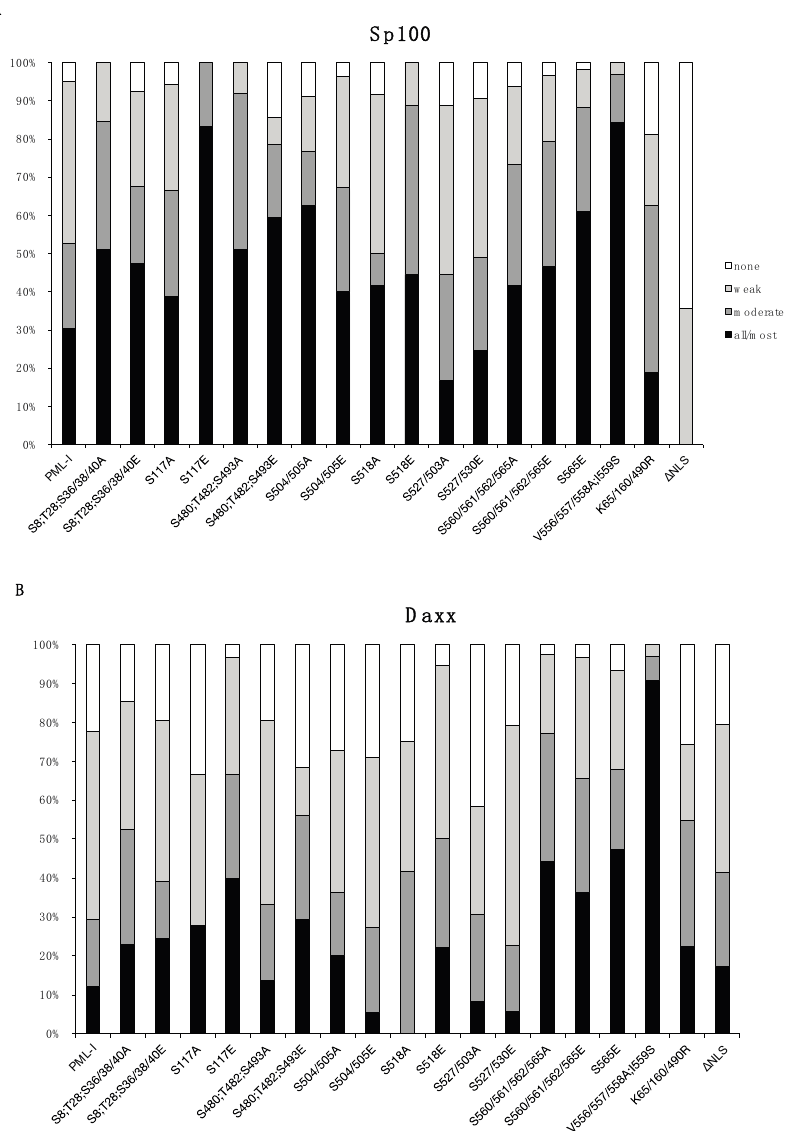
Figure 3. Quantification of Sp100 and Daxx recruitment to PML in PML-depleted A549 cells that express wild type and mutant forms of PML-I. A549-shPML cells transduced with CFP-tagged PML-I or each PML-I mutant were scored on a four-point scale based on how well they recruited Sp100 (A) or Daxx (B), with either none (none), less than 50% (weak), between 50%–90% (moderate), or >90% (all/most) of the protein being localized at ND10s, as judged using fluorescence